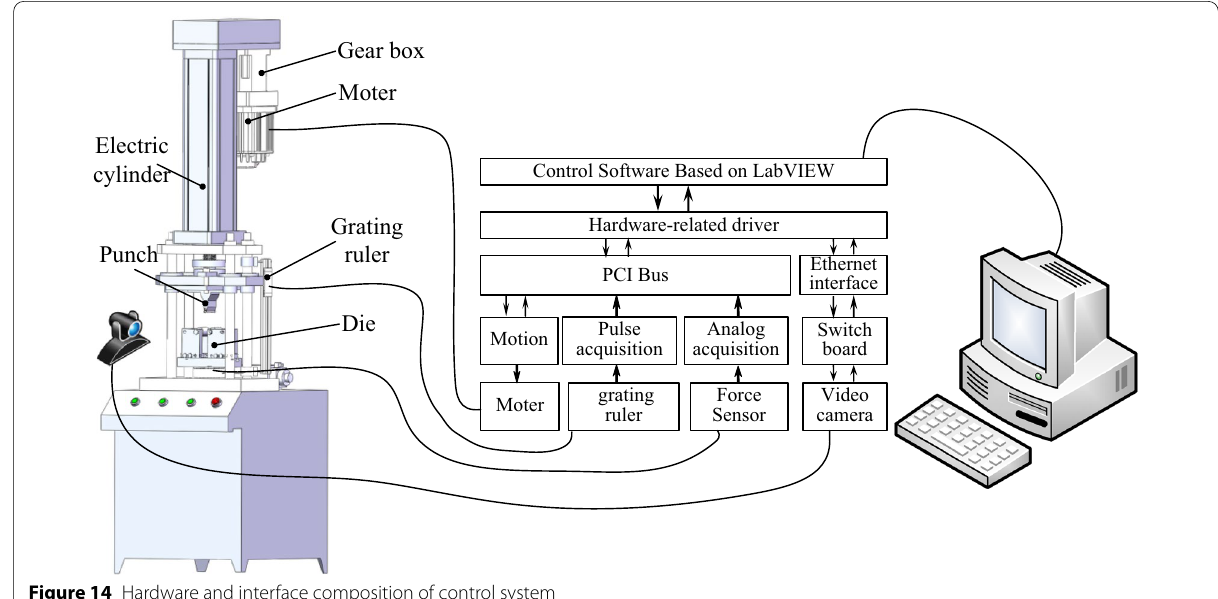
Figure 14 Hardware and interface composition of control system